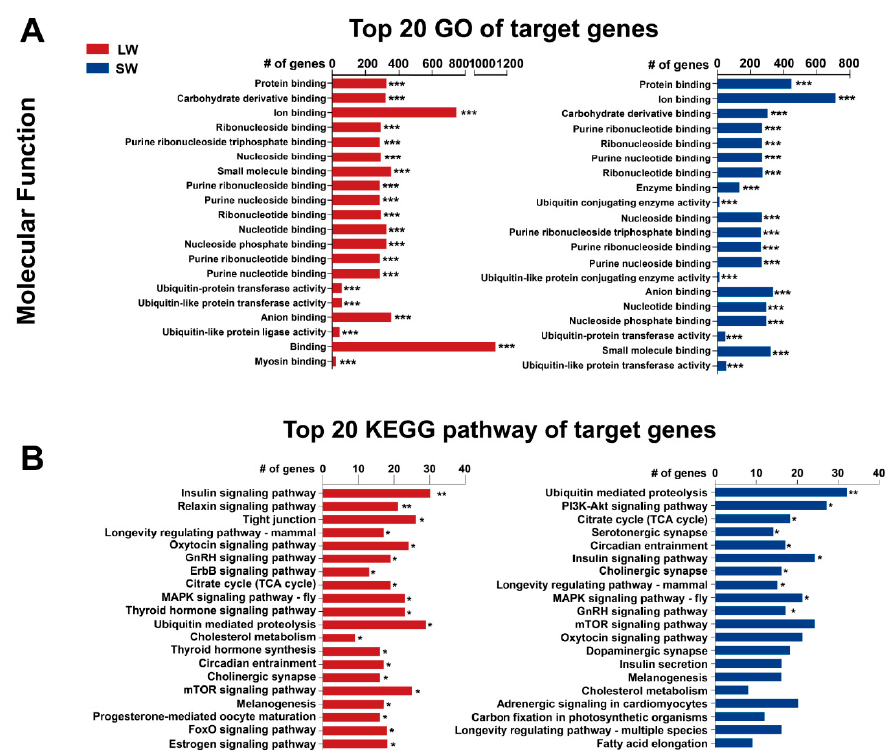
Figure 3. Gene Ontology (GO) and Kyoto Encyclopedia of Genes and Genomes (KEGG) enrichment analyses of targets of differentially expressed miRNAs. ( A ) GO molecular function terms enriched in differentially expressed miRNA-targeted genes in LW and SW strains. ( B ) KEGG pathways enriched in differentially expressed miRNA-targeted genes in LW and SW strains. * p < 0.05, ** p < 0.01, *** p <